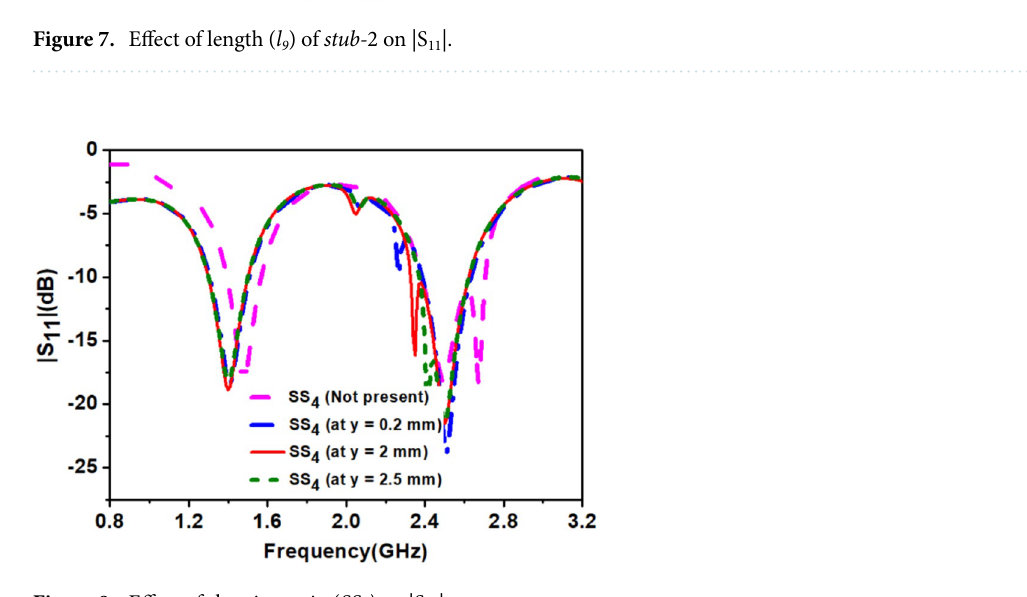
Figure 8. Effect of shorting strip ( SS 4 ) on |S 11